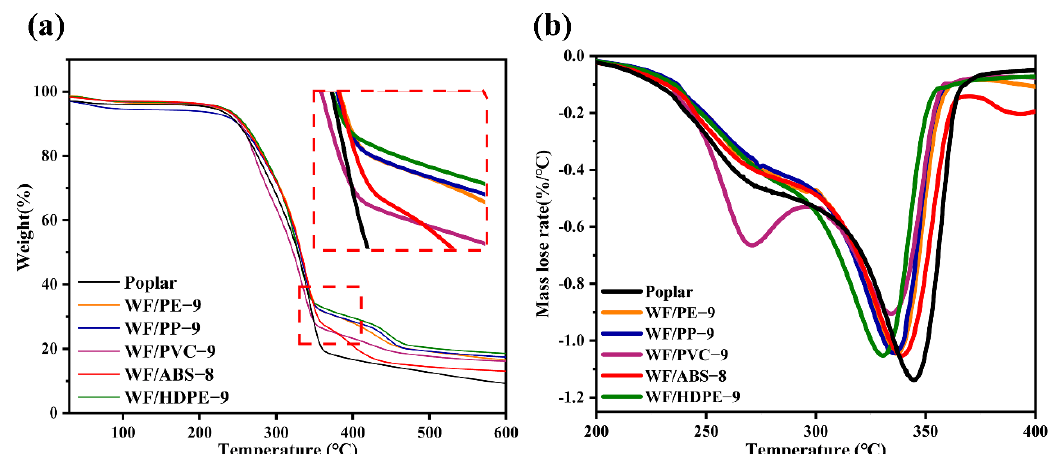
Figure 6. ( a , b ) Thermogravimetric analysis of WPC and poplar.